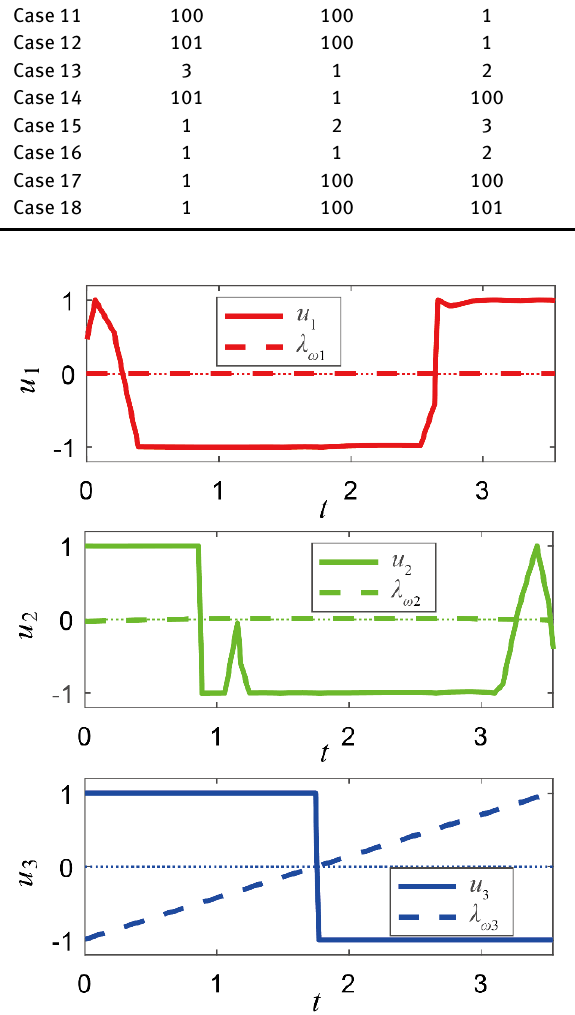
Figure 10. The optimal control histories and switching functions for Case 11.